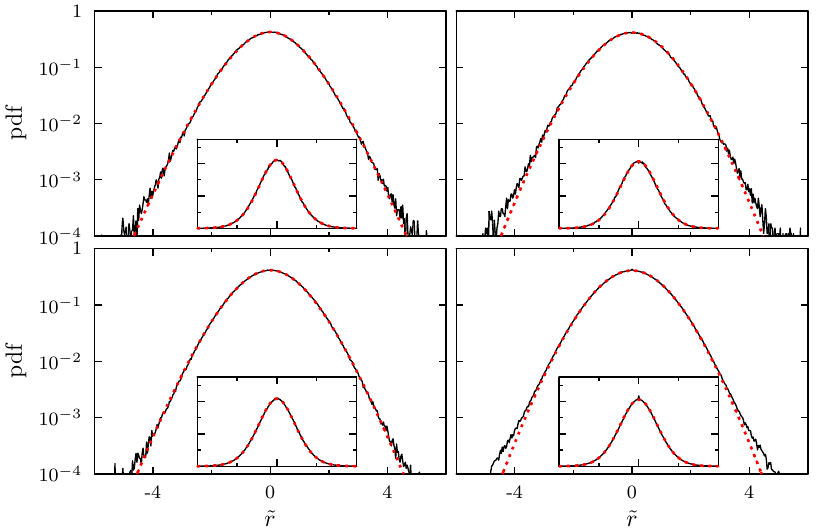
Figure 5. Aggregated distribution for the normalized monthly returns with the empirical covariance matrix on a logarithmic scale. The black line shows the empirical distribution; the red dotted line shows the theoretical results. The insets show the corresponding linear plots. Top left/right: S&P 500 (1992–2012)/(2002–2012); bottom left/right: NASDAQ (1992–2012)/(2002–2012). Reproduced with permission from (Schmitt et al. 2015), Infopro